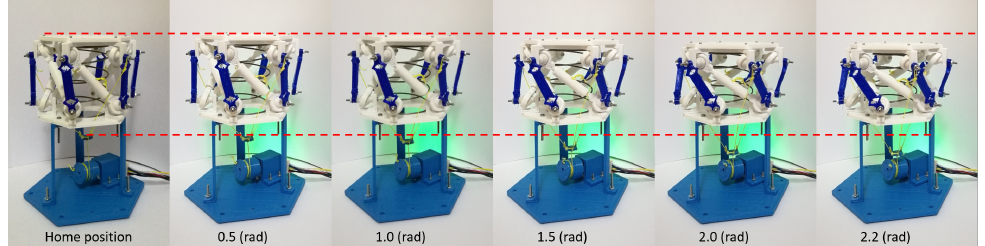
Figure 19. Prototype test results with different target